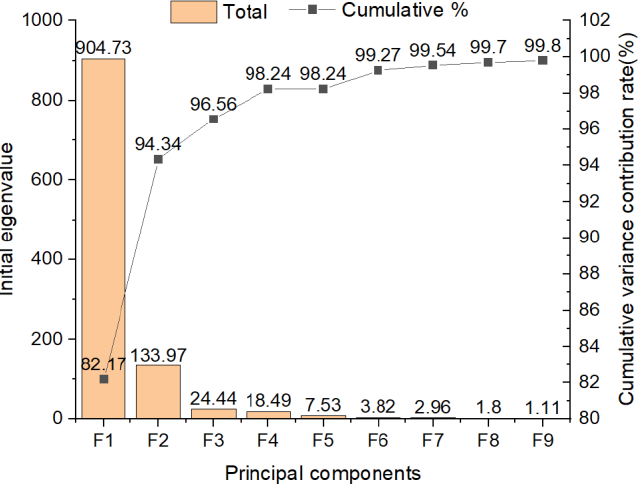
Figure 5. Principal component analysis (PCA) results of tree peony leaves spectra.